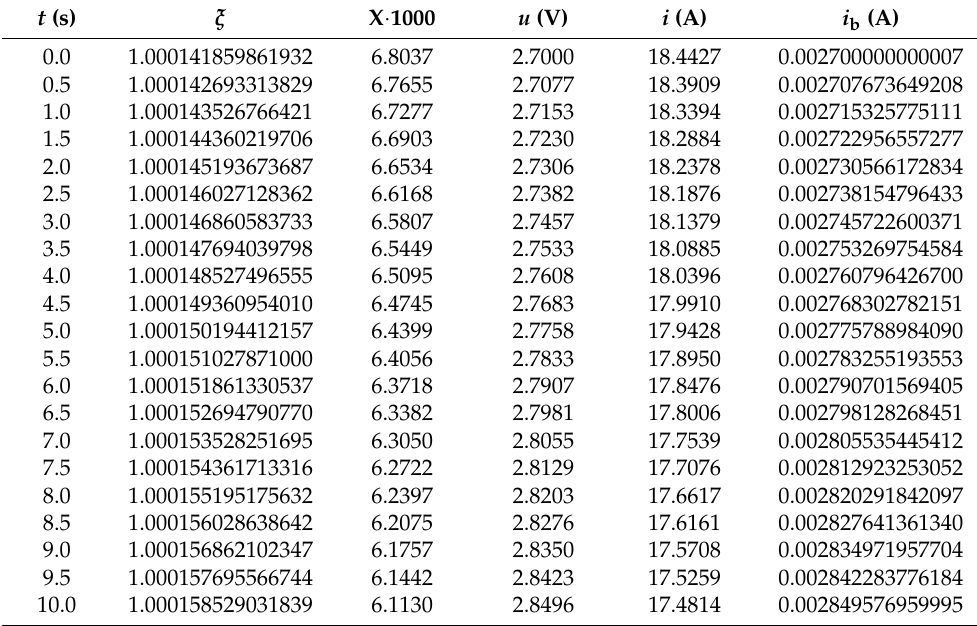
Table 5. Numerical results calculated in SC charging, R b = 1000 Ω .